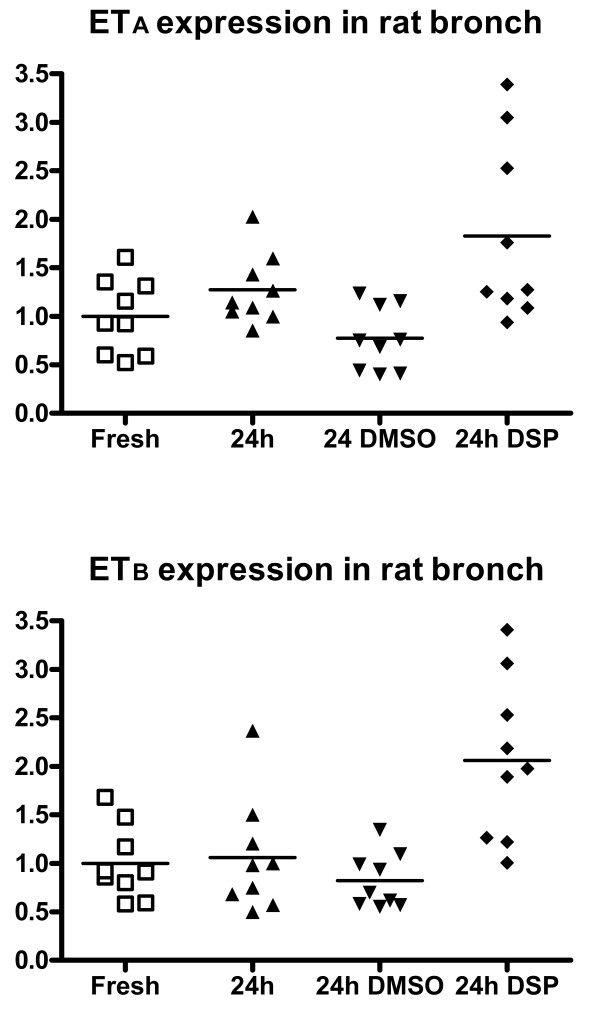
A and B; Quantitative image analysis of the bronchi for receptor protein expression under differing experimental conditions. ETA and ETB receptor protein showed a significant increase (p < 0.05) in DSP treated as compared with fresh bronchi, 24 h and 24 h+DMSO treated bronchi.